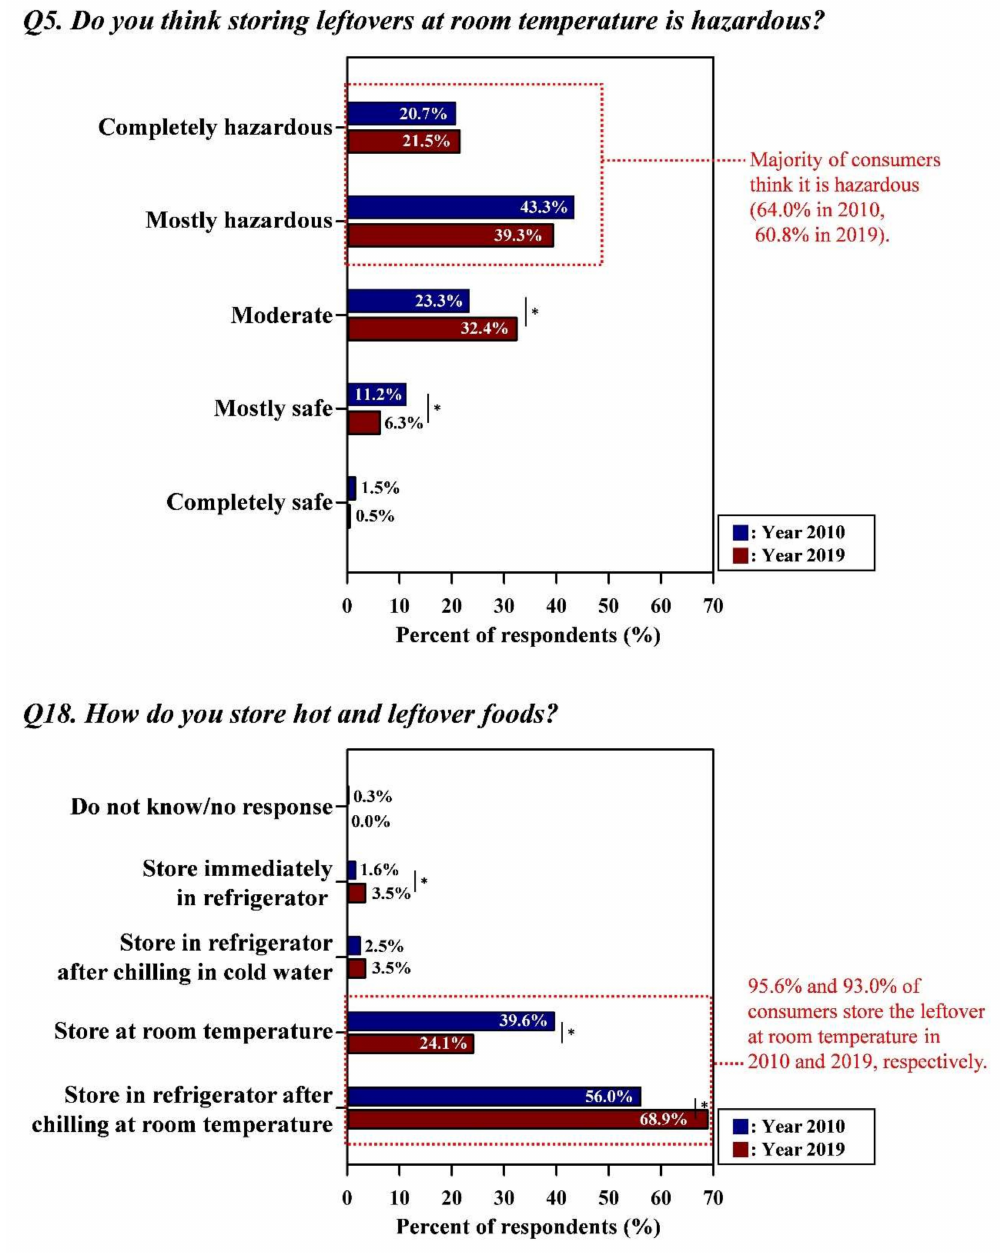
Figure 3. The gap between the consumers’ perceptions and behaviors regarding the leftovers. Asterisk (*) indicated between graphs means the significant di ff erences of responses (the Kruskal–Wallis test; p < 0.05) in each answer option from Year 2010 and Year 2019. Red letters indicated the improper risk perceptions (i.e., the response in opposition to conventional food safety guidelines) and high-risk behaviors of consumers. All data regarding the percentage of the combined answer options (e.g., Always + Frequently) are provided in Table